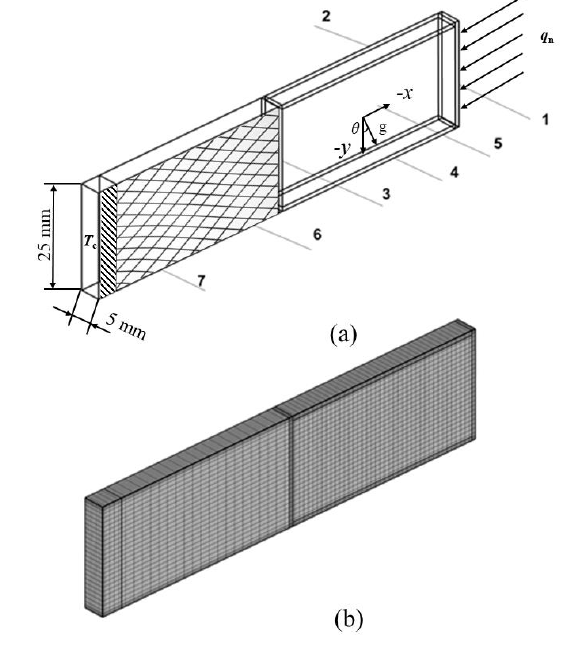
Fig. 4. Schematic diagram of computational domain and grid system: (a) the computation domains; (b) grid system. The numbers indicated in the figure are: 1-4 are aluminum extrusion regions, 5 is air region, 6 is insulation material region and 7 is the decorative material